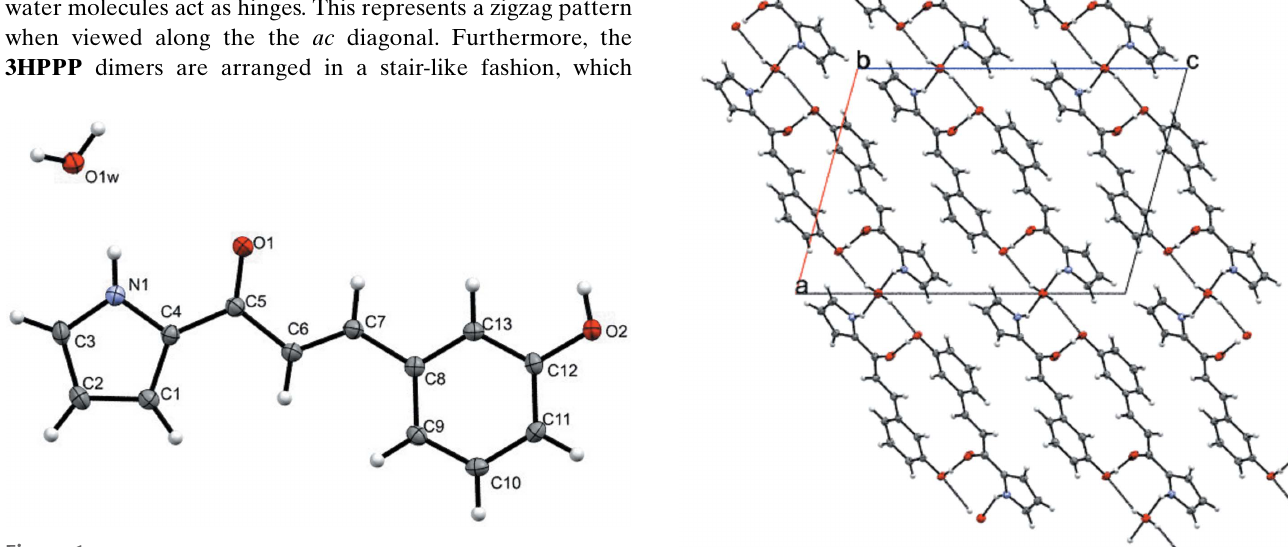
Figure 1 ORTEP (Burnett & Johnson, 1996) diagram of compound 3HPPP plus the symmetry-completed water molecule with the atom-labelling scheme and 50% probability ellipsoids.